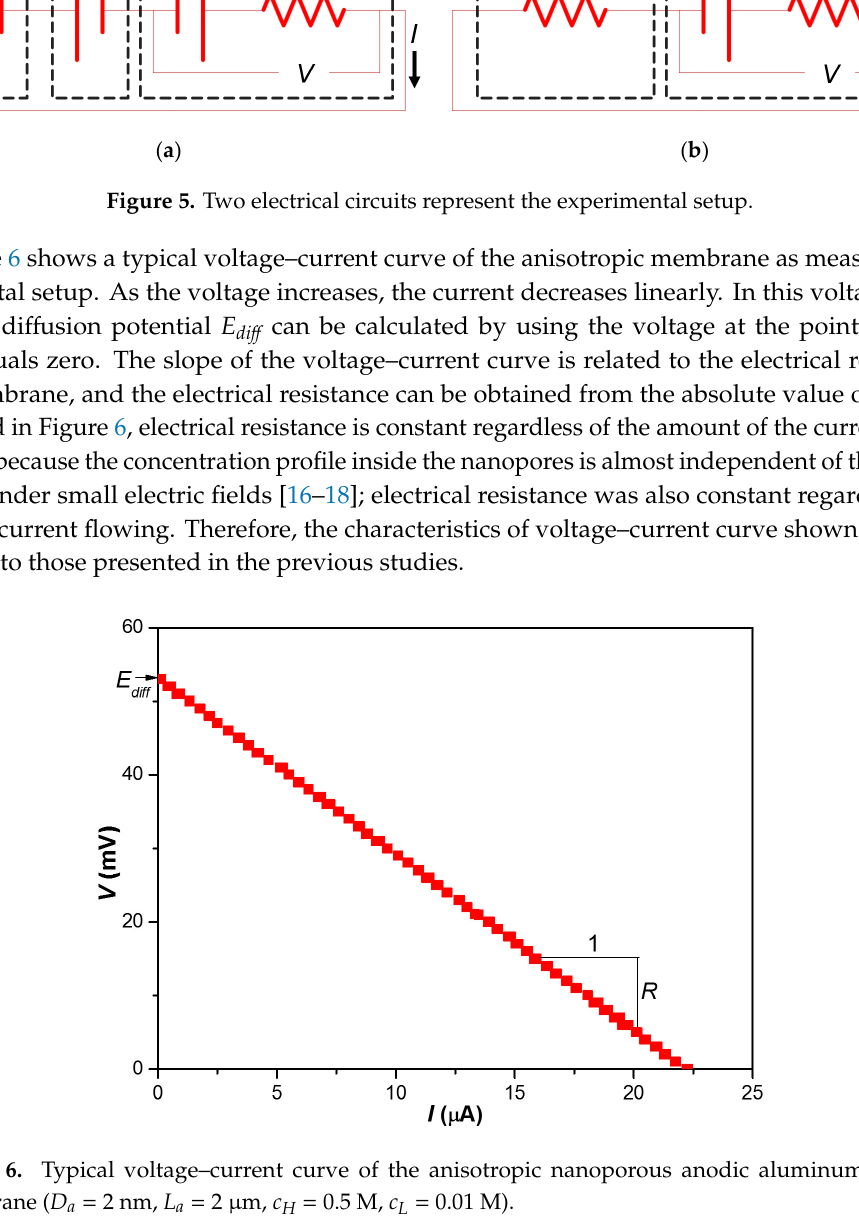
membrane ( D a = 2 nm, L a = 2 μ m, c H = 0.5 M, c L = 0.01 M).